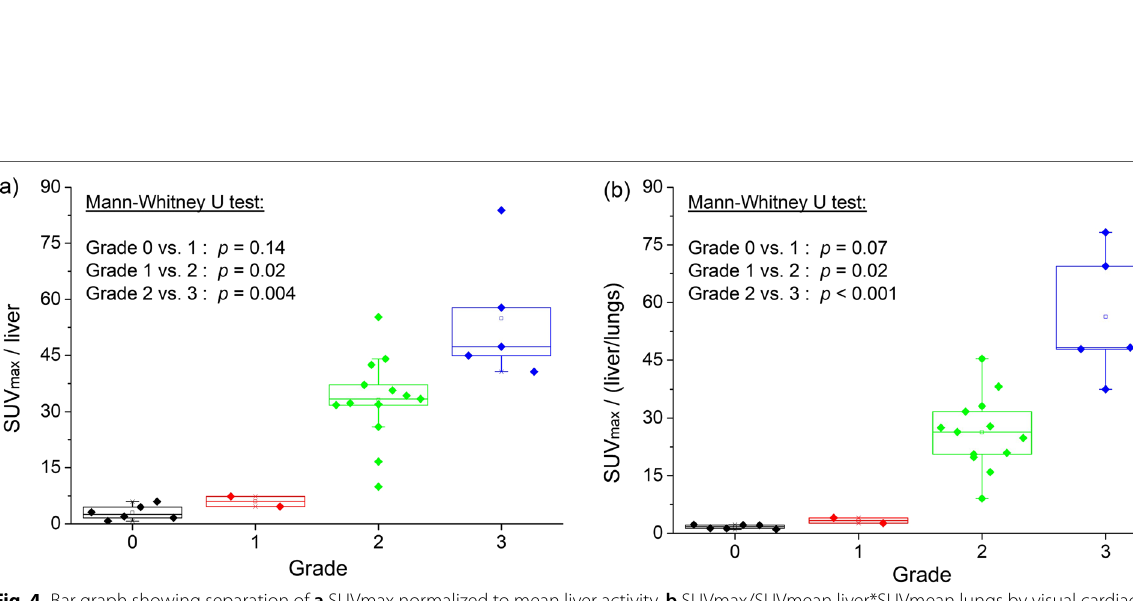
Fig. 4 Bar graph showing separation of a SUVmax normalized to mean liver activity, b SUVmax/SUVmean liver*SUVmean lungs by visual cardiac uptake grade. SUV, standardized uptake